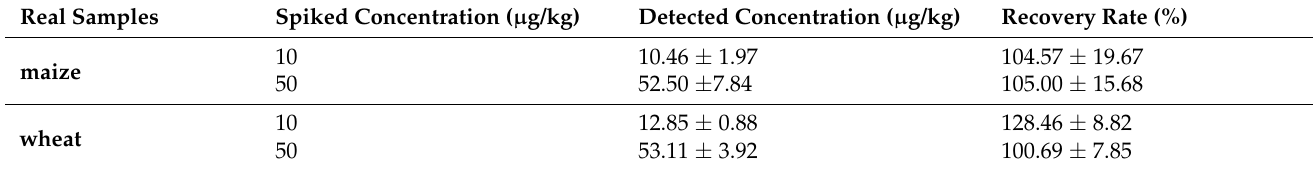
Table 2. Recovery rate for ZEN-spiked real maize and wheat samples.